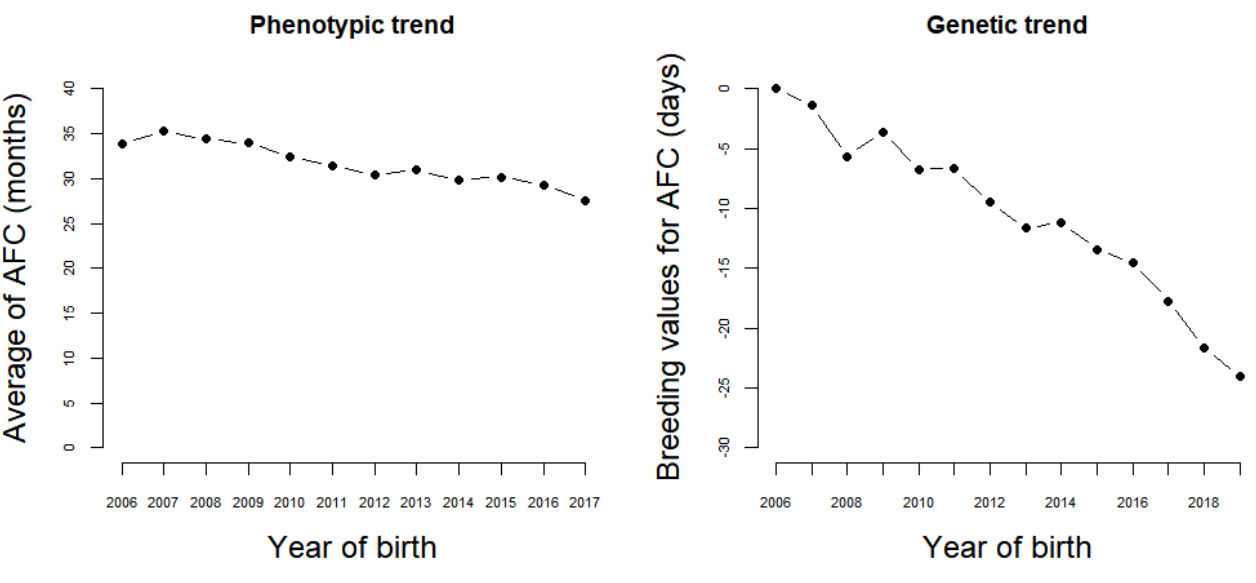
Figure 2. Phenotypic and genetic trend for age at first calving.